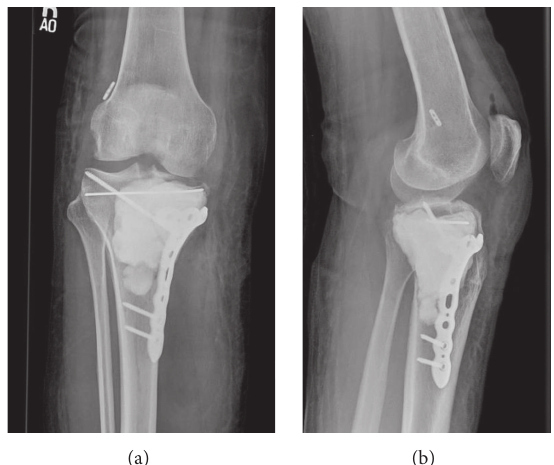
Figure 8: AP and lateral view radiographs immediately after curettage and packing of the proximal tibial giant cell tumor along with medial collateral ligament (MCL) repair; prophylactic fixation of the right